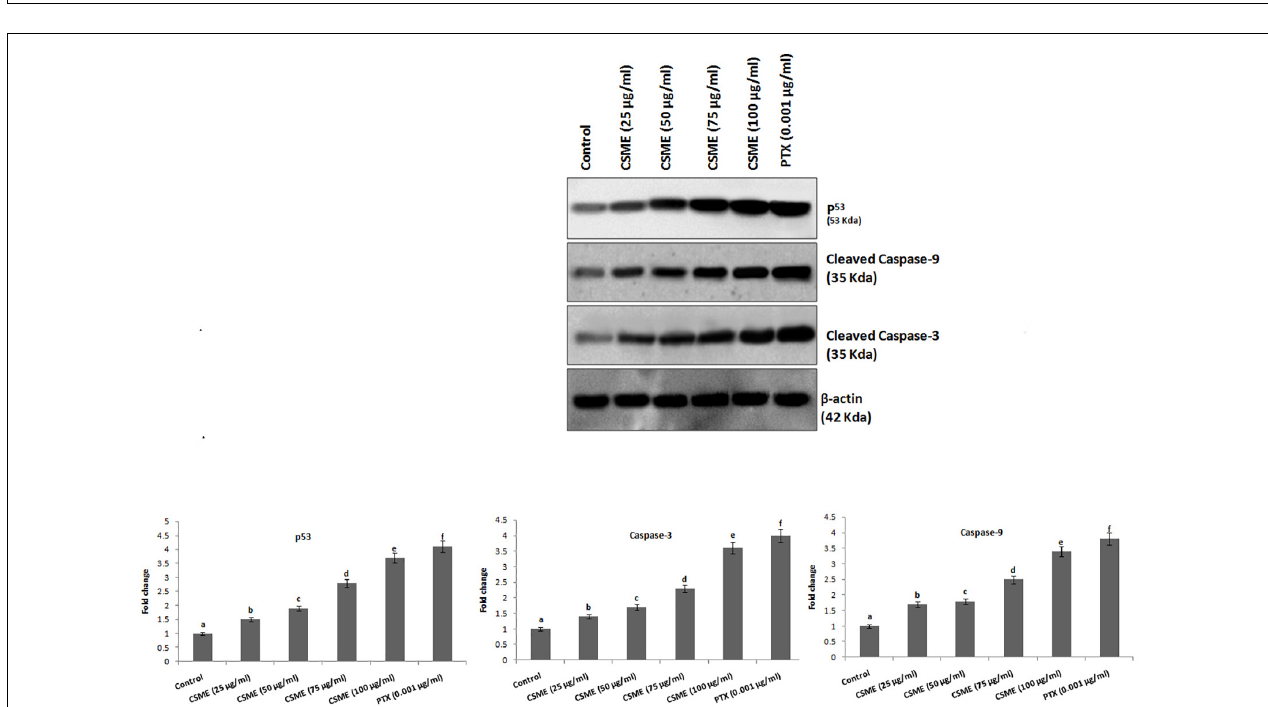
FIGURE 7 | CSME induces upregulation of apoptotic markers expression in MDA-MB-231 cells. Western blot analysis was carried out to demonstrate the apoptotic effect of CSME treatment in MDA-MB-231 cells. Immunoblots were performed with cell lysate to determine the apoptotic protein expression such as p53, cleaved caspase-9, and cleaved caspase-3 by western blot analysis. Protein quantification was performed by densitometry analysis in Image Studio Software (LI-COR). Expressions were normalized with β -actin as the mean ± SD. P < 0.05 versus untreated control MDA-MB-231 cells from three independent experiments.